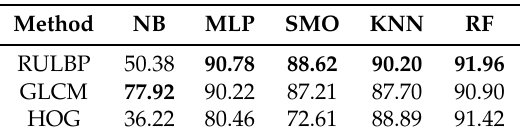
Table 4. Performance comparison in terms of recognition accuracy (in %) of GLCM, HOG and RULBP ( th = 105) on the present dataset for five different